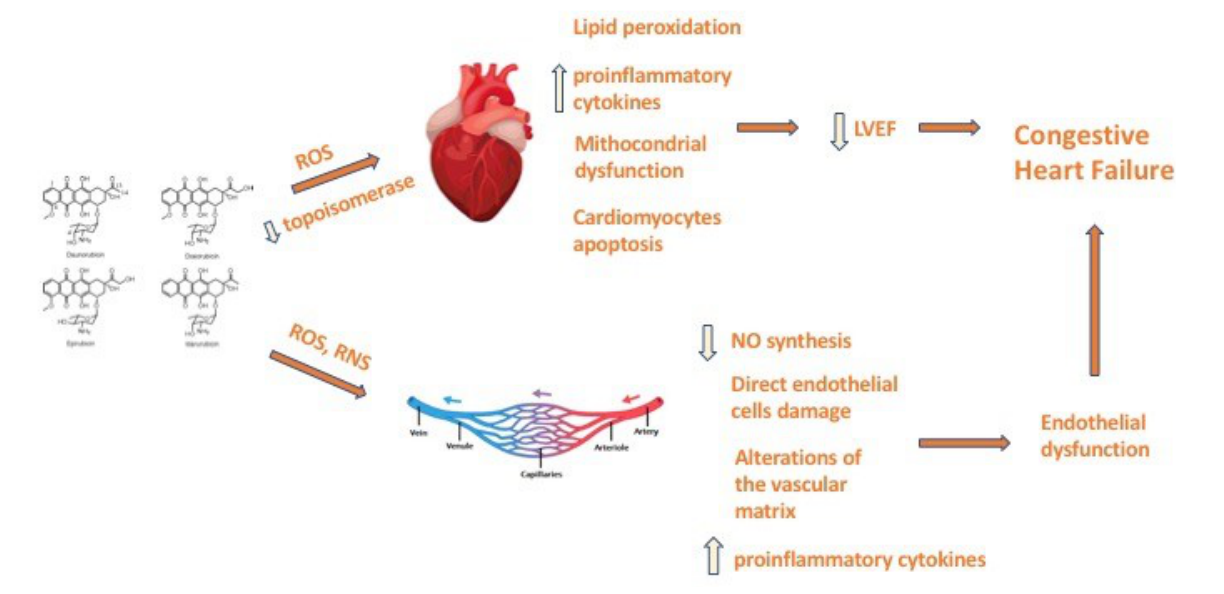
Figure 1. Molecular mechanisms of anthracyclines induced cardiotoxicity. LVEF, left ventricle ejection fraction; NO, nitric oxide; RNS, reactive nitrogen species; ROS, reactive oxygen